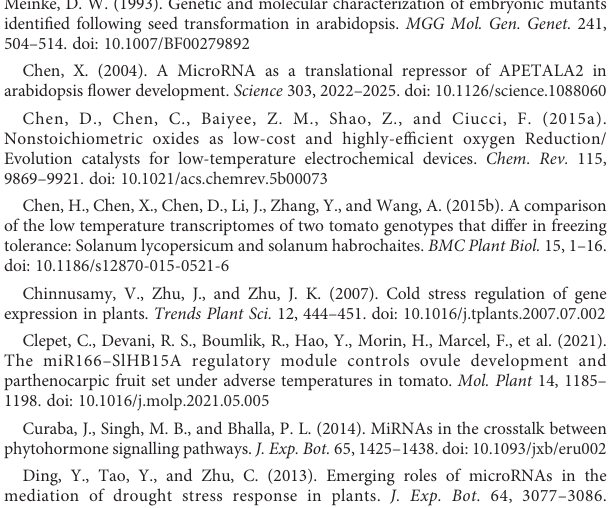
Overview of the high-throughput sequenced sRNA libraries.